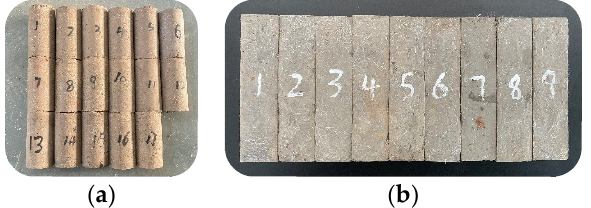
Figure 5. Composite material samples. ( a ) Uniaxial compression test samples ( b ) Three-point bending test sample.